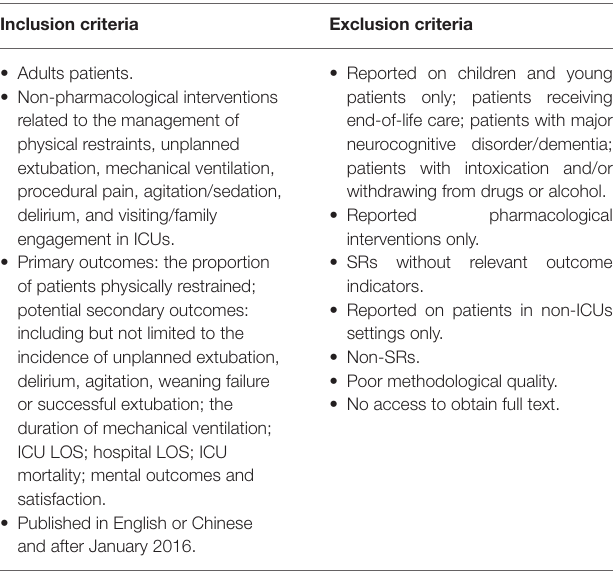
TABLE 1 | Inclusion and exclusion criteria of systematic reviews and